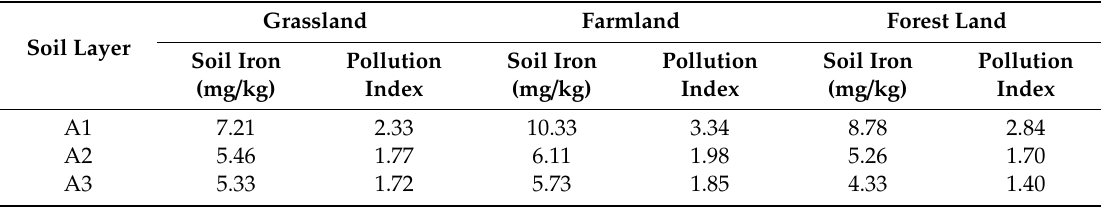
Table 5. Soil iron content and pollution index under di ff erent land uses. Grassland Farmland Forest Soil Layer